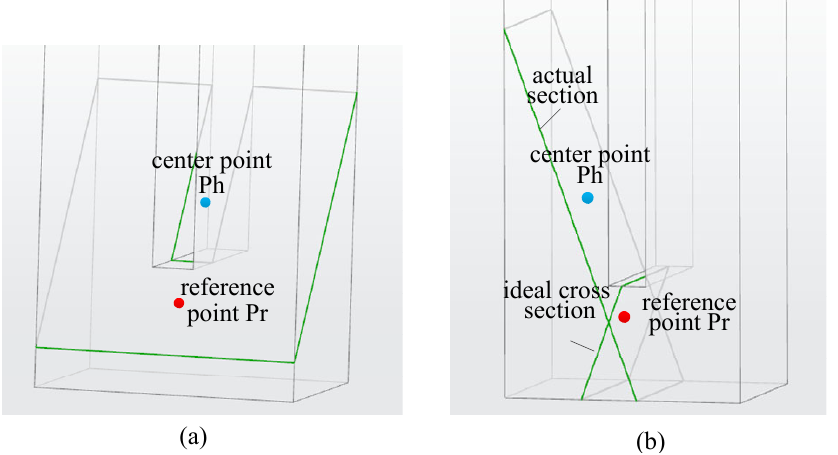
Figure 7. Schematic representation of iterative optimization criteria: ( a ) judgment of unevenness condition, and ( b ) judgment of distance